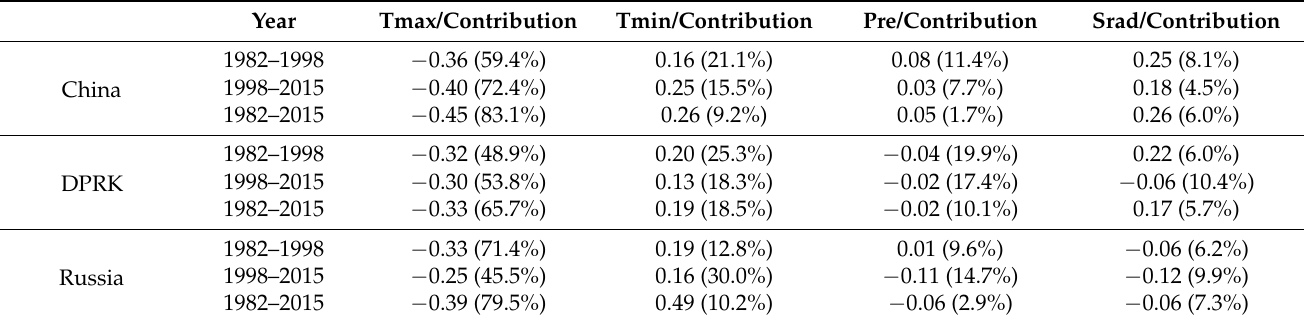
Table 1. Partial correlation coefficient between SOS and different climatic factors and contribution of main influence climatic